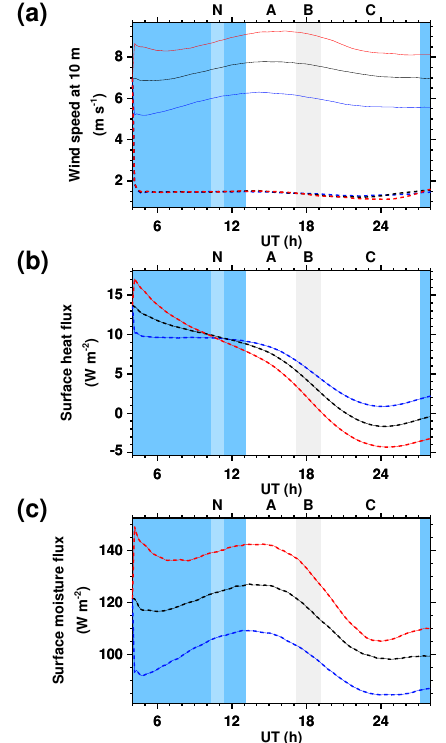
− 0 (blue), L (black), − 0 buoy (blue), L buoy